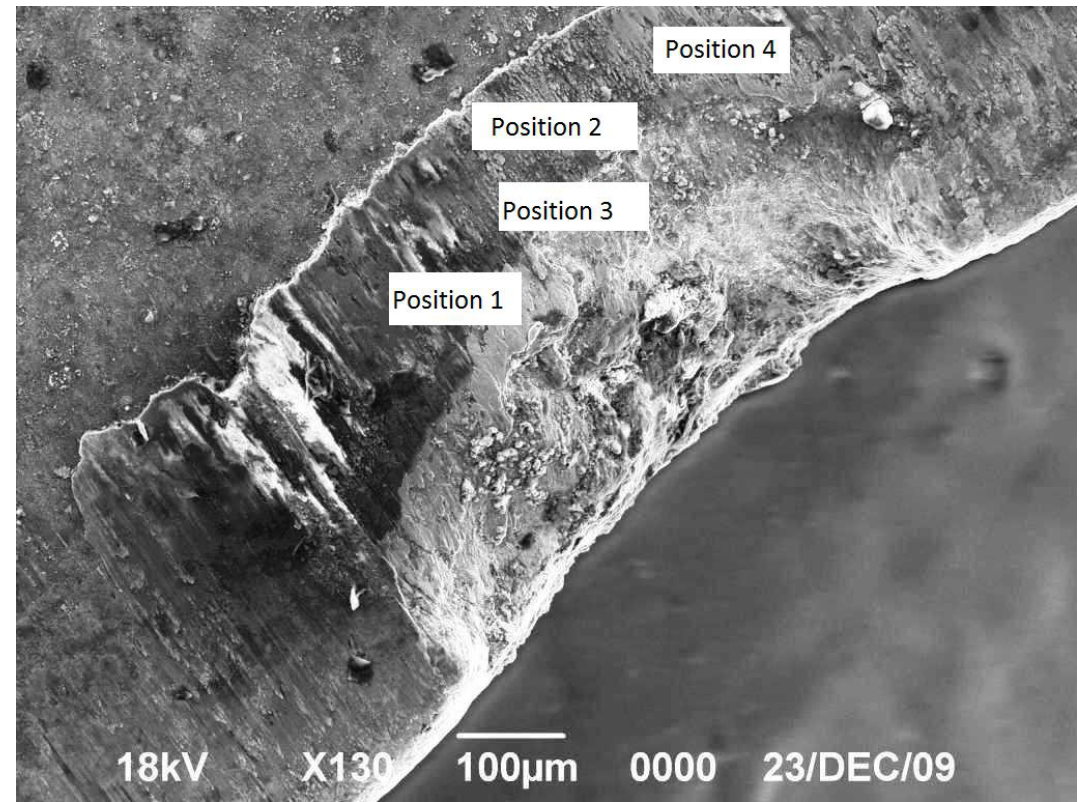
Figure 1. Scanning electron microscopy (SEM) micrograph of the notch wear of one of the coated carbide inserts used in this